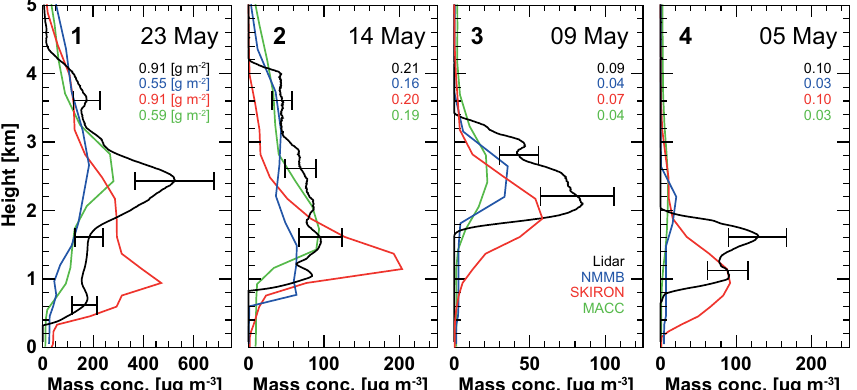
Figure 6. Dust mass concentration profiles observed with lidar (black, with retrieval uncertainty bars) and simulated with NMMB/BSC-Dust (blue), SKIRON (red), and MACC/CAMS (green) for cases 1–4. Column-integrated dust mass concentrations are given as